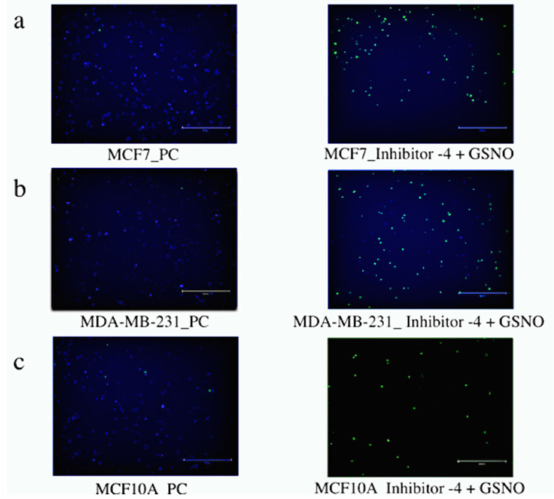
Figure 9. Live/dead cytotoxicity images for Group 2 MCF7 ( a ) and MDA-MB-231 ( b ) breast car- cinoma cell lines as well as the normal breast cell line MCF10A ( c ). Images were captured using fluorescence microscopy. Live cells exhibited blue fluorescence while dead cells exhibited green fluorescence. For each cell line, the images on the left side represent untreated PC cells and the images on the right represent the S cells (Group